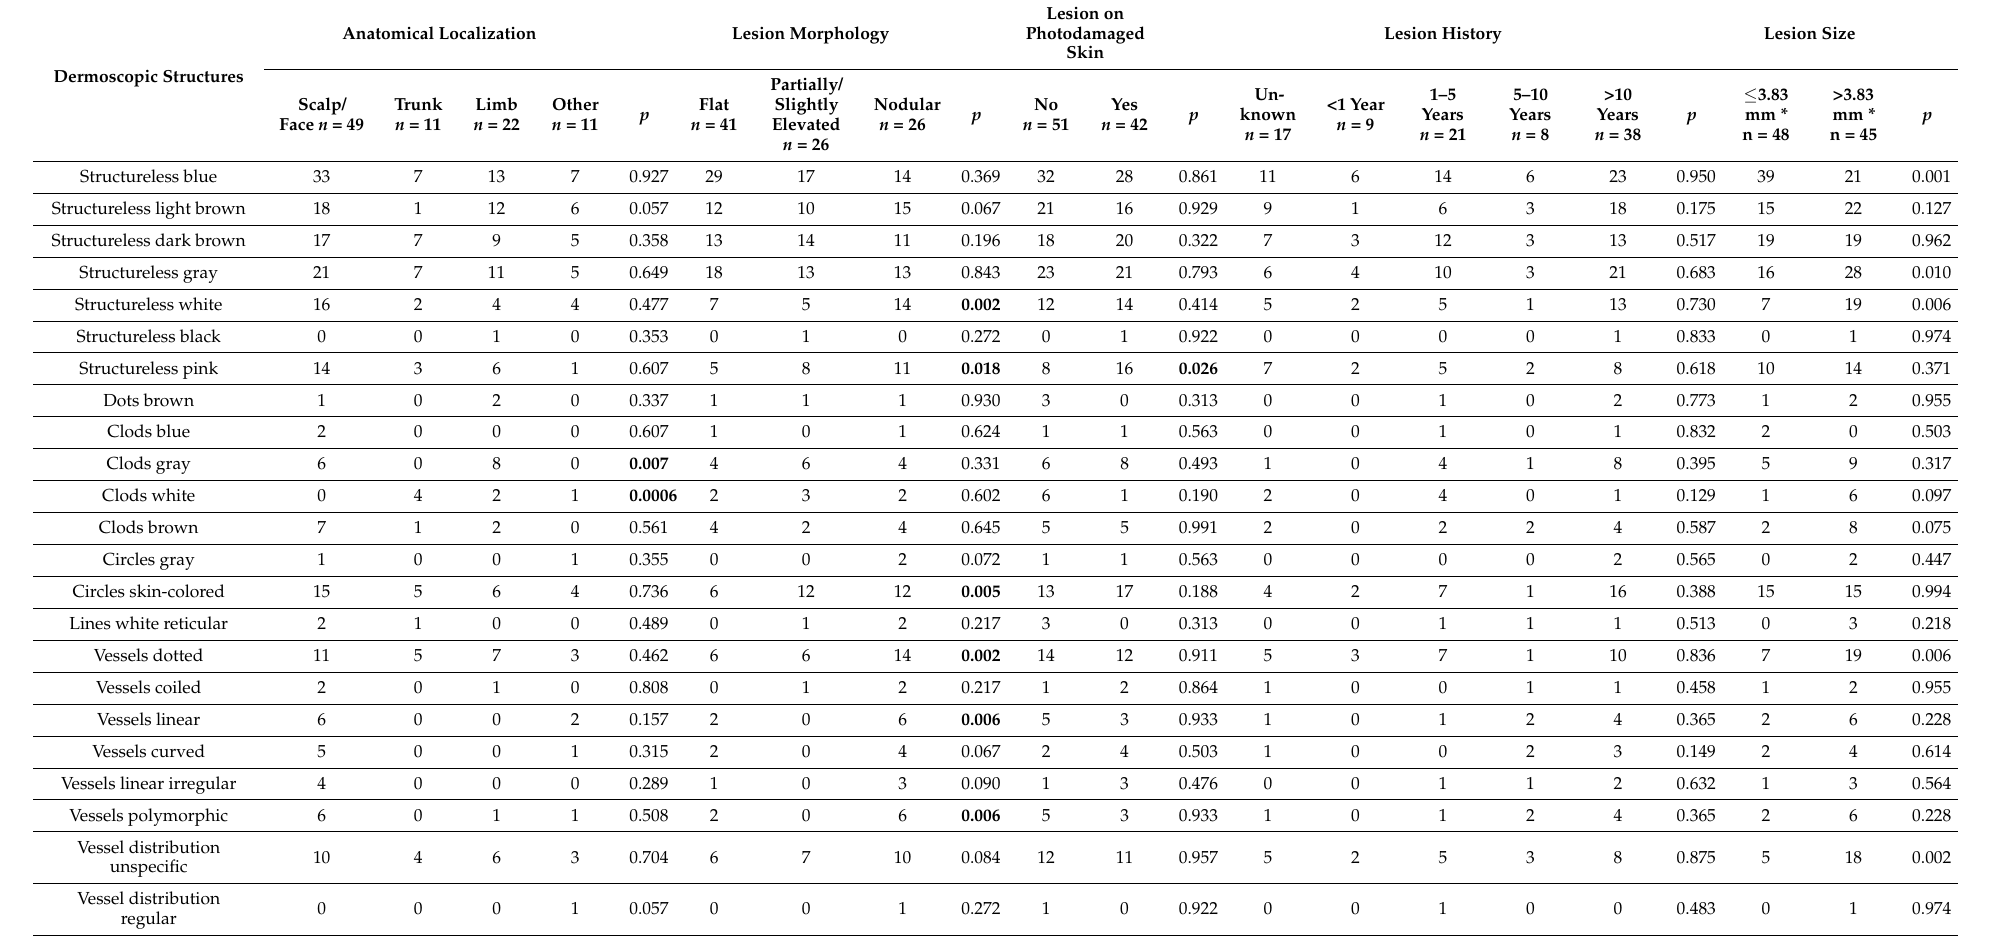
Table 2. The frequency of dermoscopic features in the study group according to the lesion-related